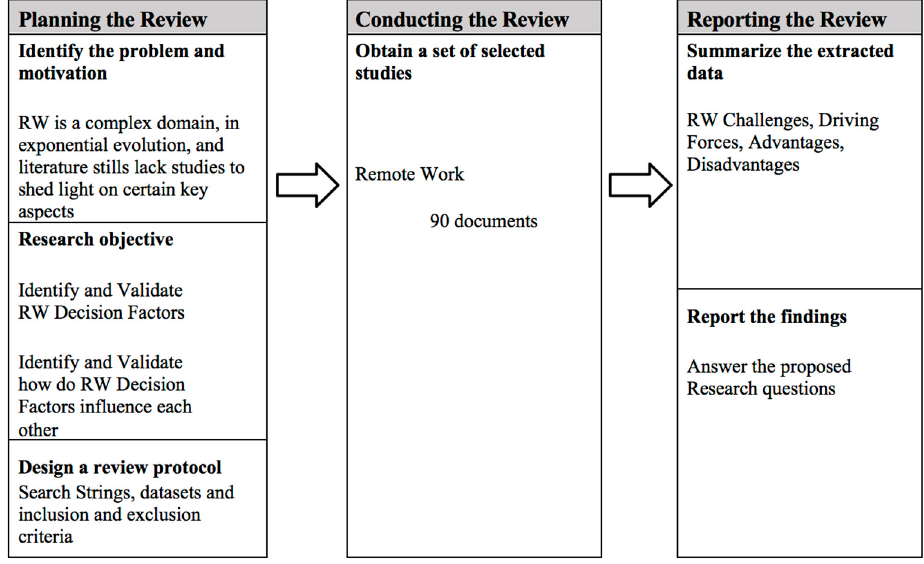
Figure 2. Diagram of the performed SLR methodology for remote work (RW) decision factors.